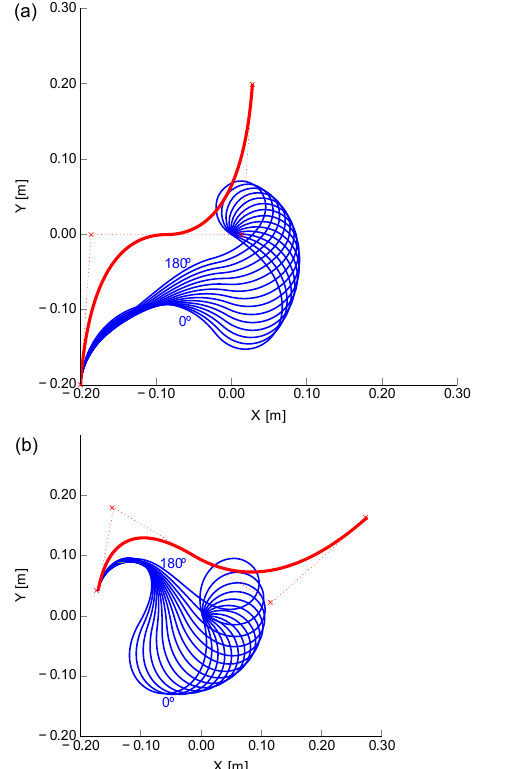
Figure 8. Example 2: shape in neutral position (red) and at the 15 increments of applied rotation of the endpoint about the origin (blue). (a) Initial shape and (b) optimum shape.